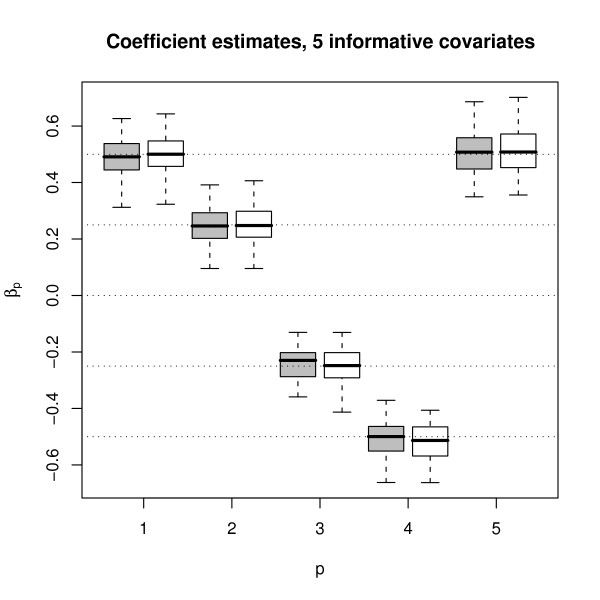
Boxplots of the Weibull parameter estimates when 5 informative covariates are present. Boxplots of the estimates of β = (0.5, 0.25, -0.25, -0.5, 0.5)⊤, as obtained from the 50 Weibull-distributed samples following Model (10). Grey boxplots correspond to boosting estimates, white boxplots correspond to maximum likelihood estimates. Similar results were obtained for the log-logistic and lognormal models.